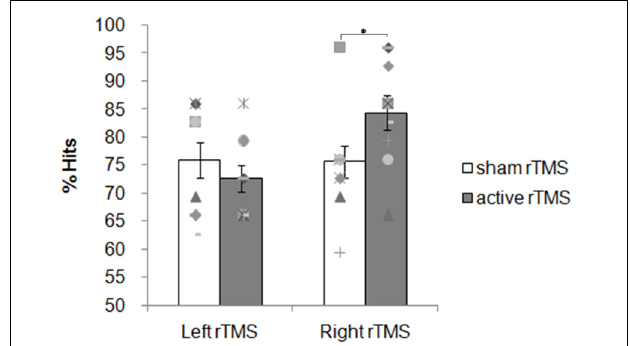
FIGURE 4 | Experiment 2: 1 Hz rTMS of the PPC before the retrieval phase. Mean percentage of subjects’ correct responses and individual performances. Each symbol represents one participant; bar plots represent the average over participants, and error bars indicate standard